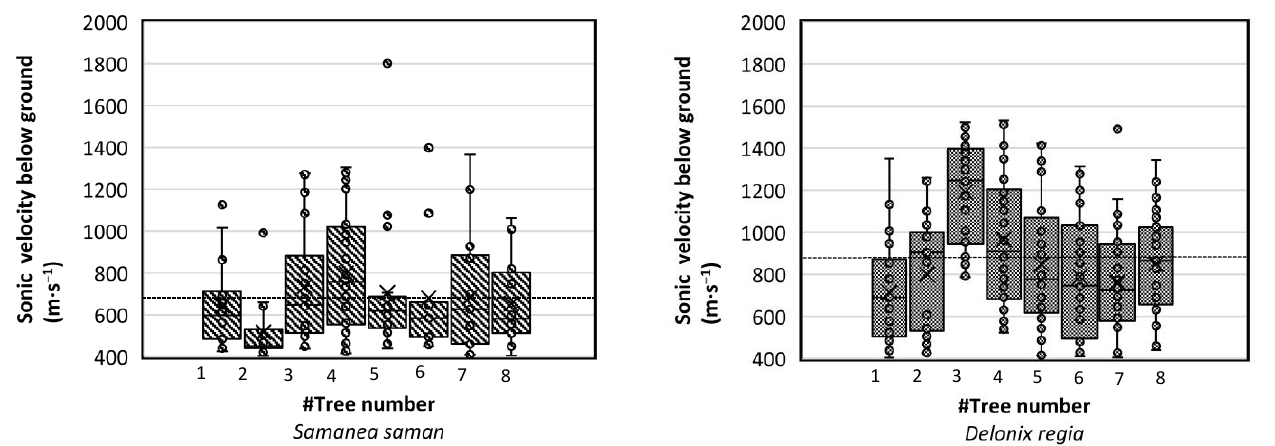
Figure 8. The root woody biomass sonic velocity (m · s − 1 ) detected by the Root Detector for Samanea saman and Delonix regia for all trees at about 80 cm distance from the trunk. The dash line (—) is the average value of root sonic velocity.